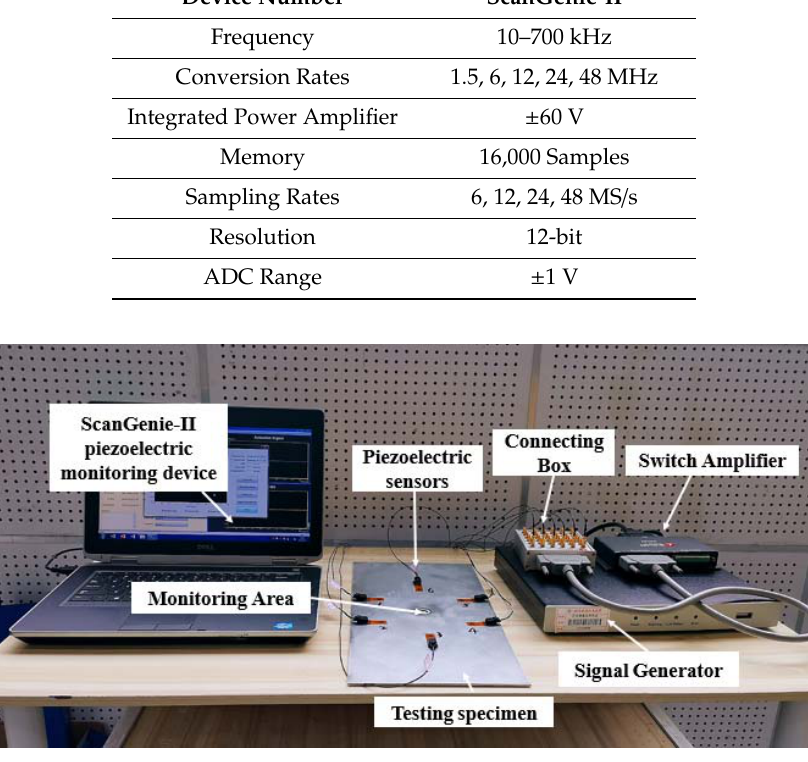
Figure 5. The experiment device. Table 1. Piezoelectric monitoring equipment technical indicators.